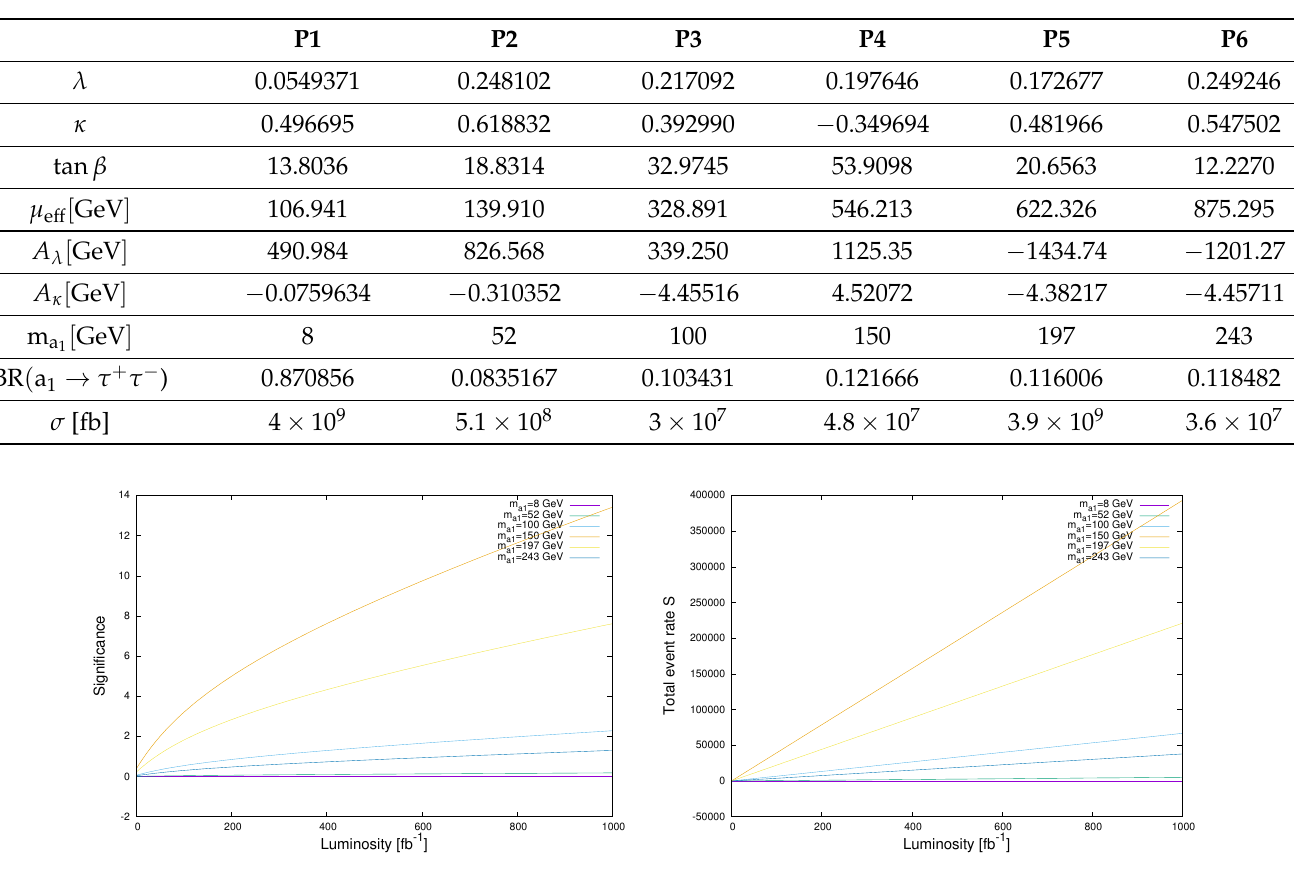
Table 2. The benchmark points used in the signal-to-background analysis for the process b ¯ b → a 1 → τ + τ − [57].